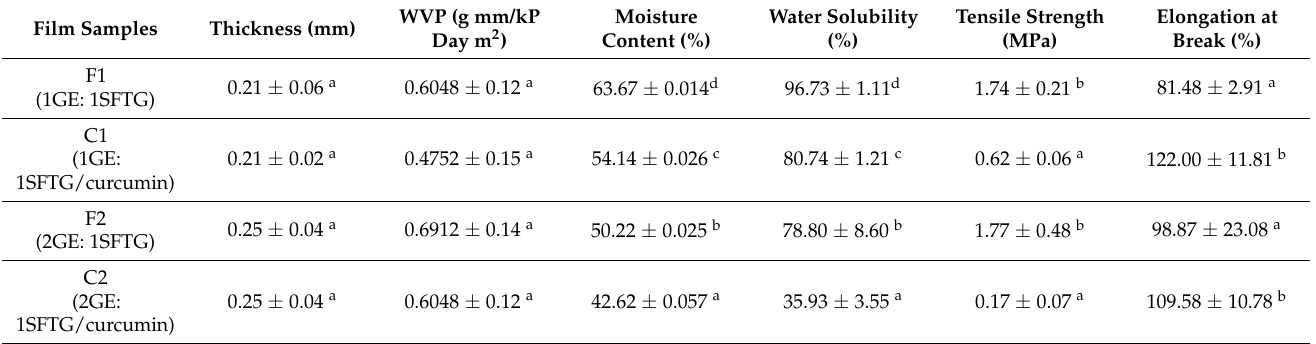
Table 2. Physical and mechanical properties of curcumin-loaded active film